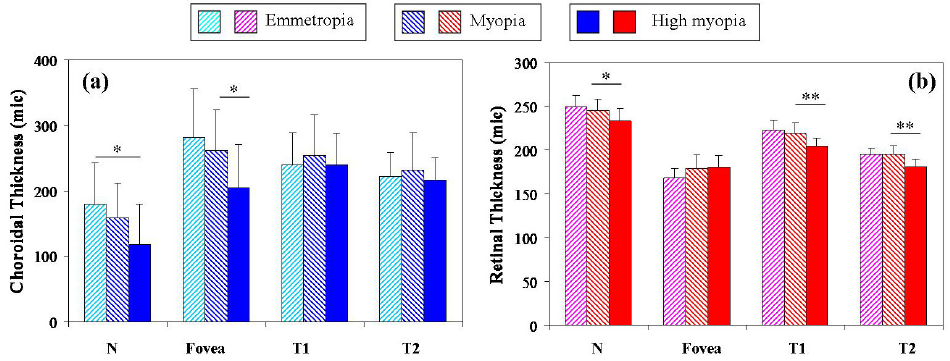
Figure 9. Choroidal ( a ) and retinal ( b ) thickness versus location in myopic and high myopic eyes. Each bar corresponds to the mean value for all eyes of an experimental group at the indicated location.